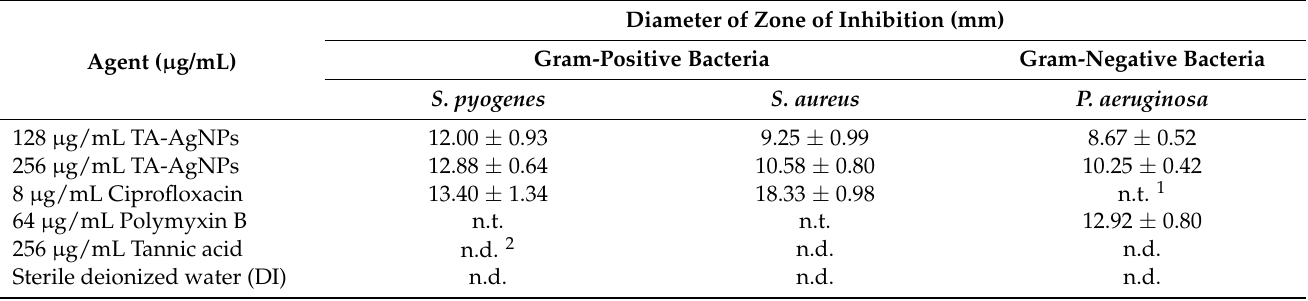
Table 1. Diameter of zone of inhibition of TA-AgNPs against bacteria causing wound infection.